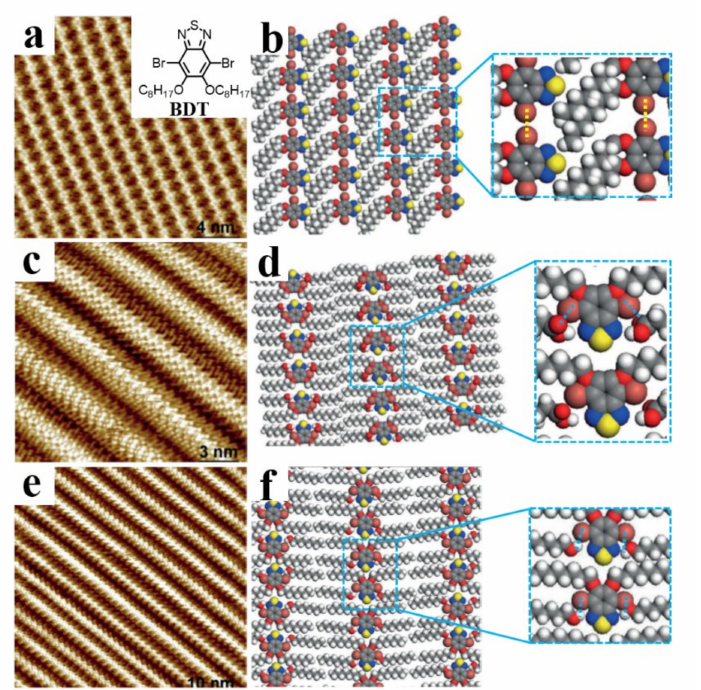
Figure 7. ( a , c , e ) High resolution STM images of DBT adlayers in 1-phenyloctane, 1-octanoic acid, and 1-octanol, respectively. ( b , d , f ) proposed structure models of ( a , c , e ) for the DBT adlayers. Possible interactions are shown in the enlarged insets by yellow and blue dashed lines. Reproduced from [79] with permission from the Hindawi.